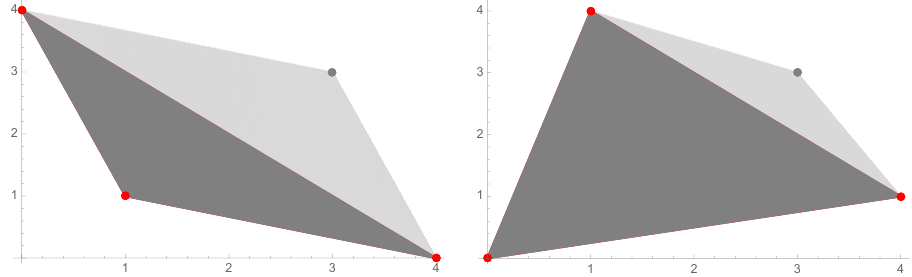
Figure 2. Payoff polygons for games